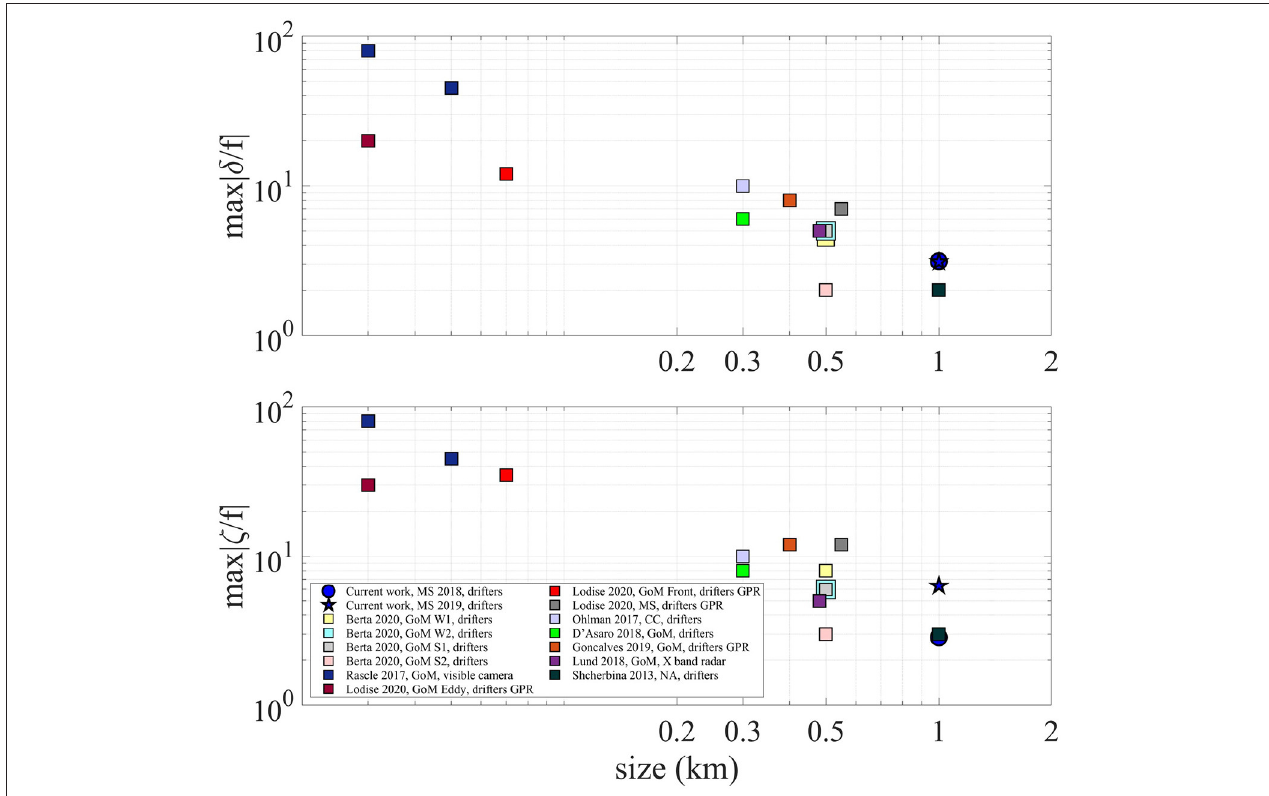
FIGURE 13 | Scale dependence of the maximum divergence (upper) and maximum vorticity (lower) for surface values from the literature and from present results. Adapted from Figures 3.20, 3.21 by Lodise